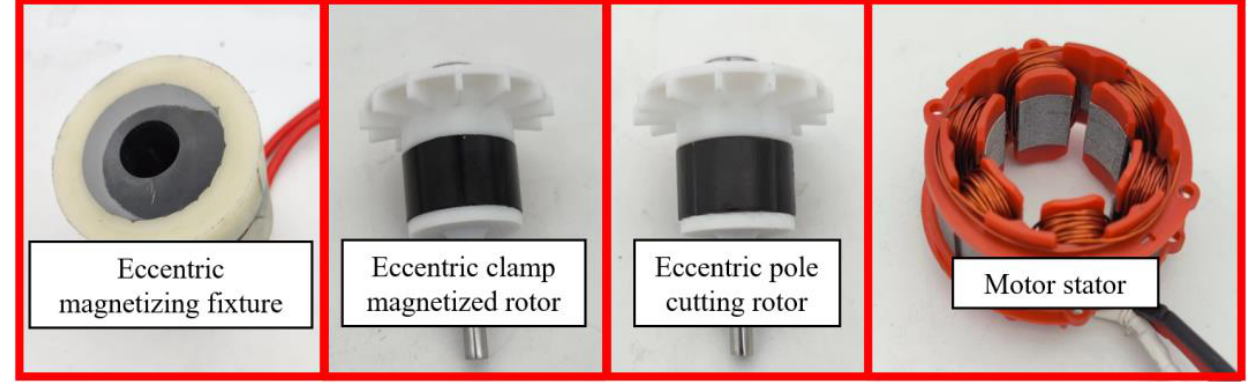
Figure 13. Eccentric magnetizing fixture and rotor stator used for test.